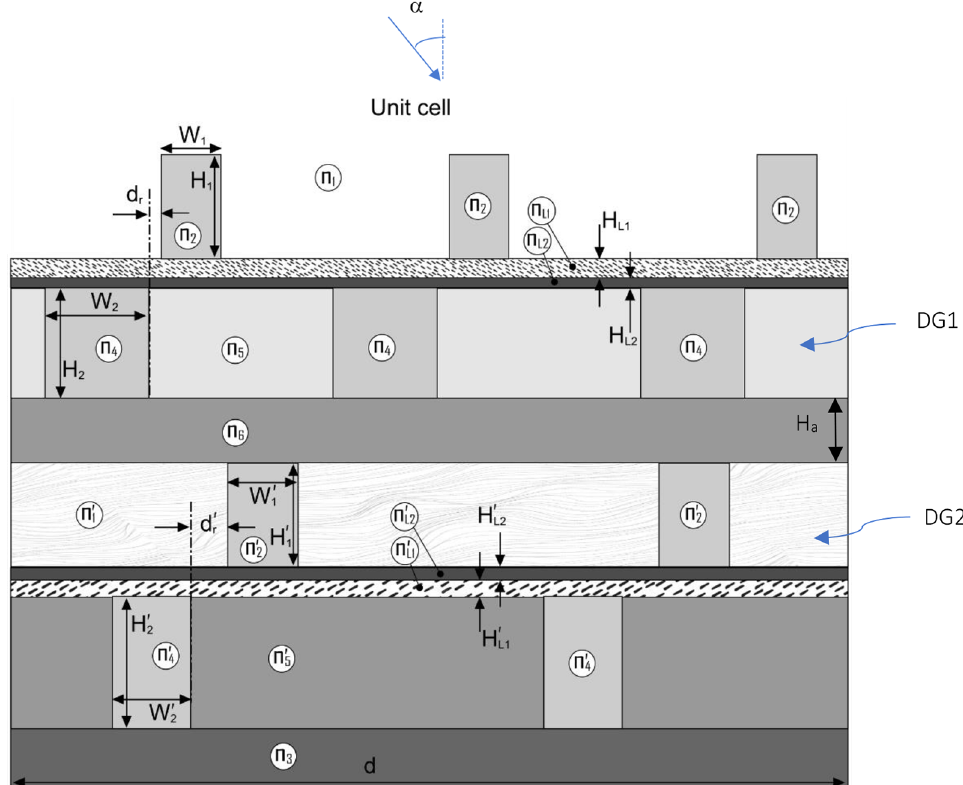
Fig. 10. Cross-sectional view of the unit cell of the metasurface on top of the